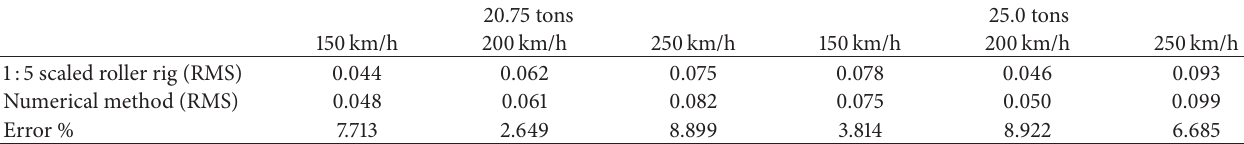
Table 4: Comparison of the RMS values for the experimental and numerical results for a vehicle horizontal acceleration of 0.49 m/s 2 .